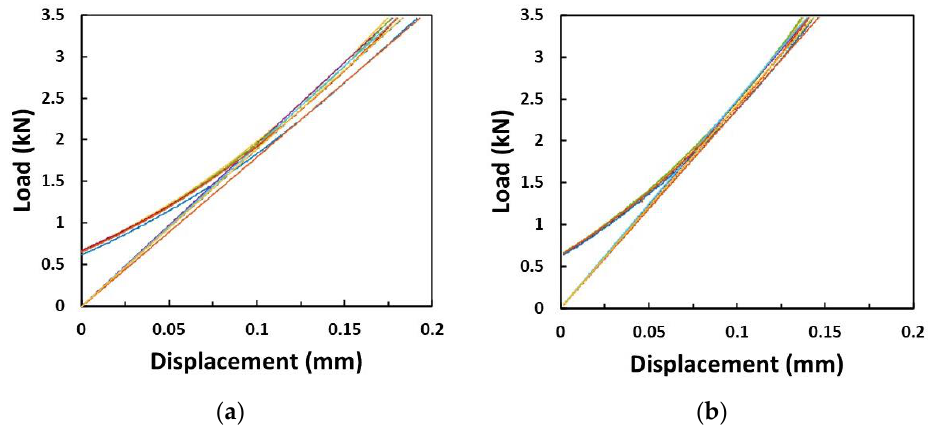
Figure 19. Load vs. Displacement charts for ( a ) specimen DM4 and ( b ) specimen CM3 tested in compression.